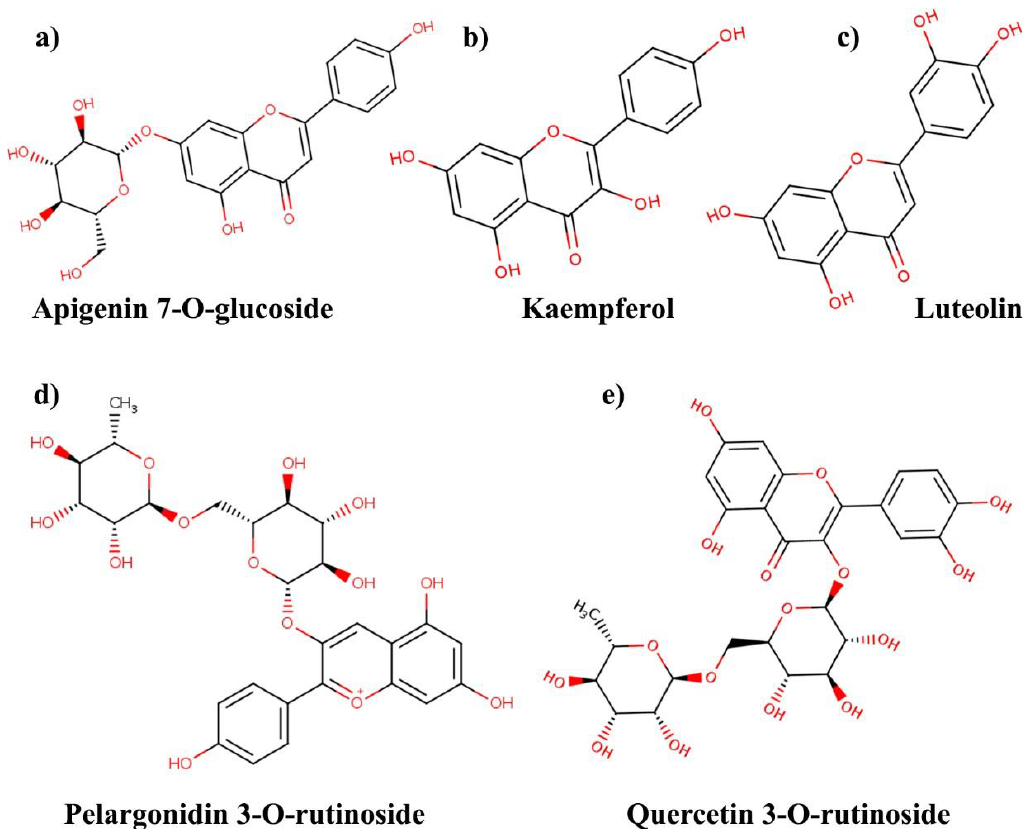
Figure A1. Structures of the identified flavonoids